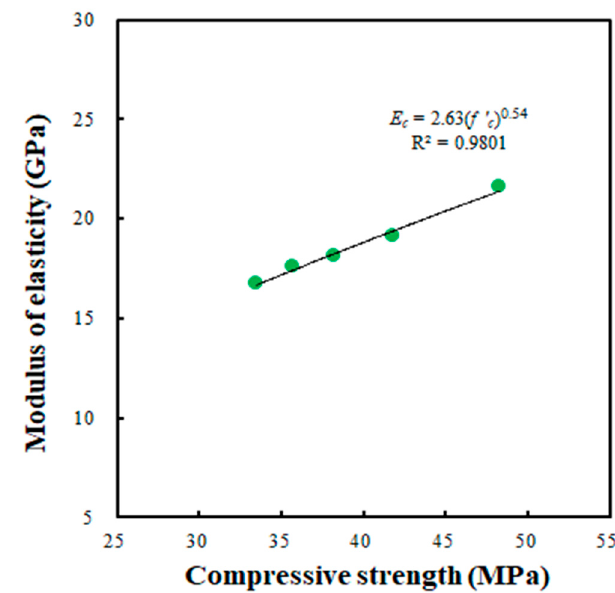
Figure 9. Relationship between the EVA/cement ratio and modulus of elasticity.